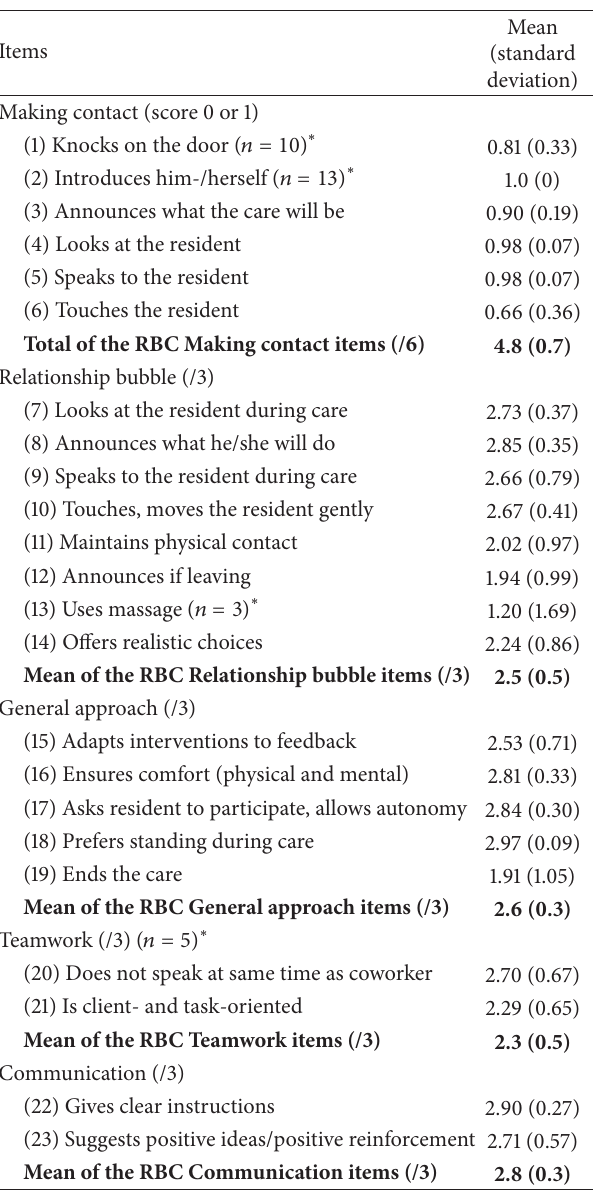
Table3:MeanscoresforRBCitemsobtainedbythecaregiverswhen assisting residents ( 𝑛 = 14 with some exceptions) with hygiene and dressing.